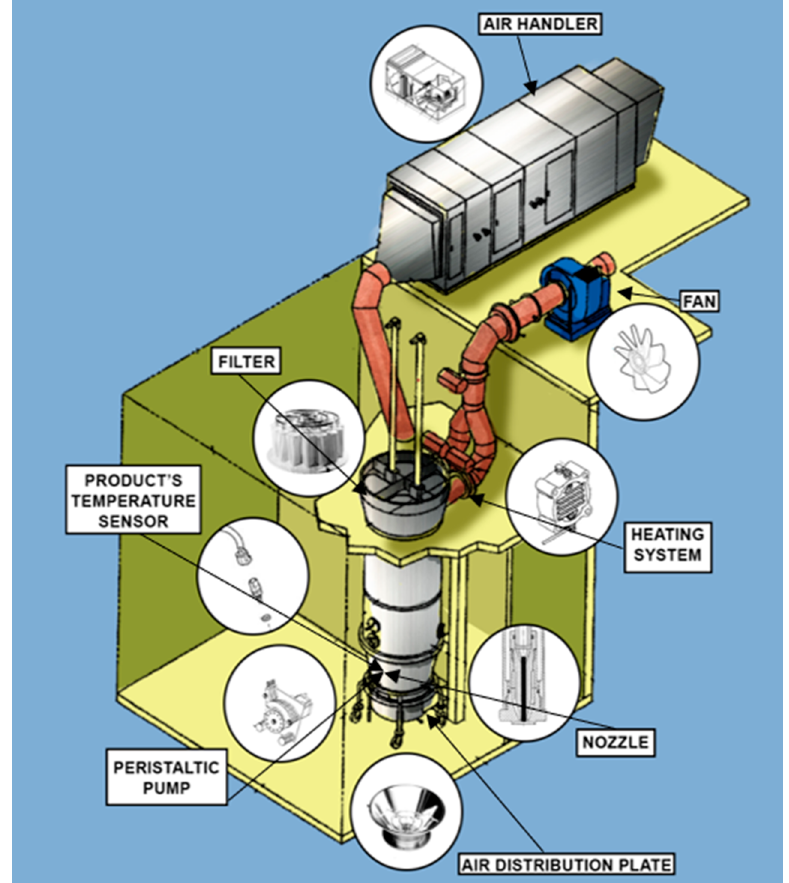
Figure 1. Granulator with the evidence of the components.